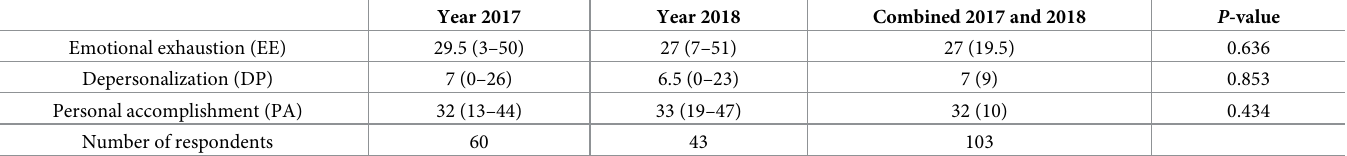
Table 2. Comparison of scores (median and interquartile range) of burnout with Maslach Burnout Inventory (MBI) for University of California Davis house offi- cers in 2017 and